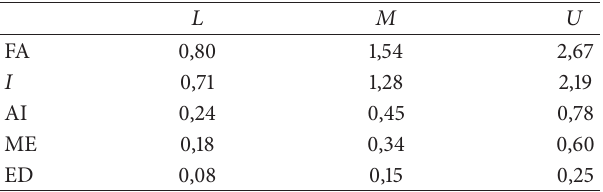
Table 14: Values of 𝑊